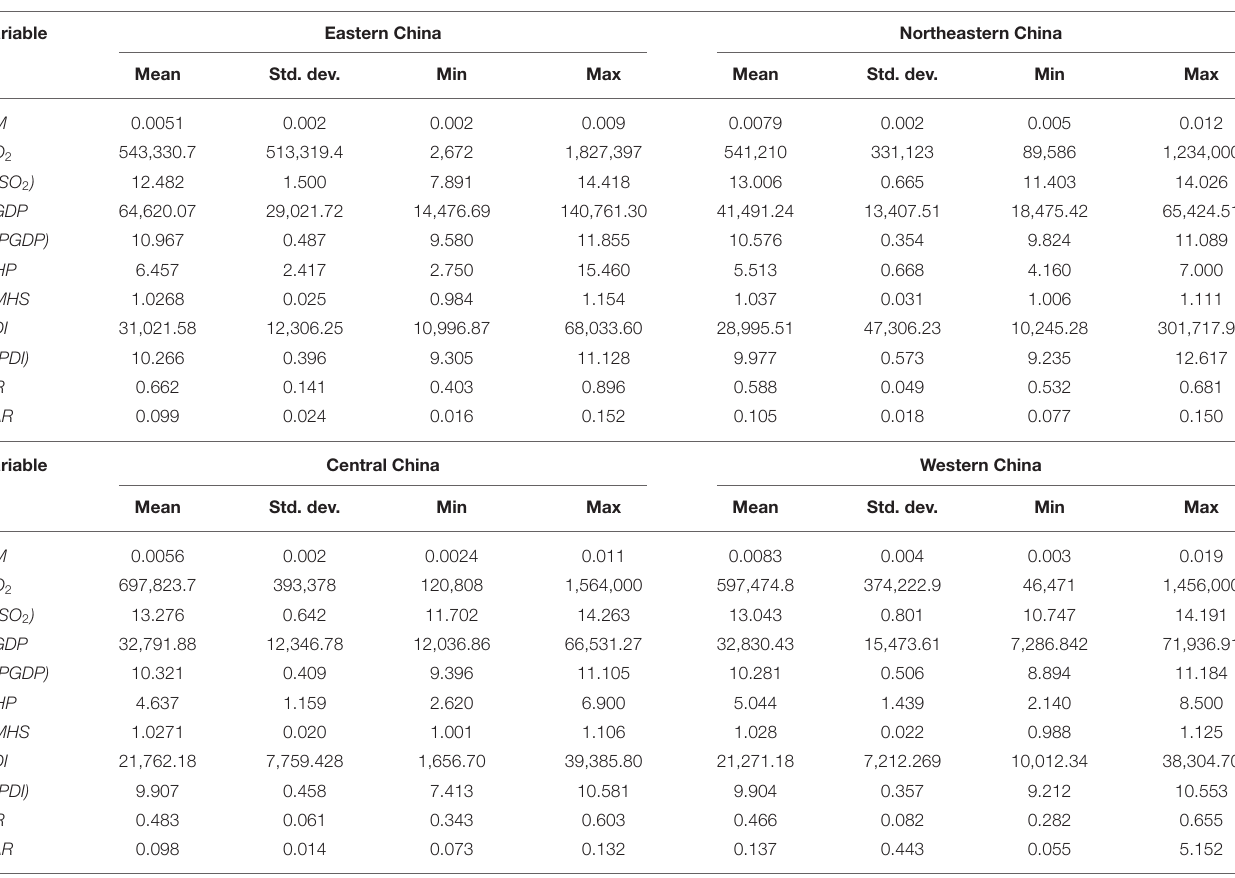
TABLE 1 | Descriptive statistical analysis